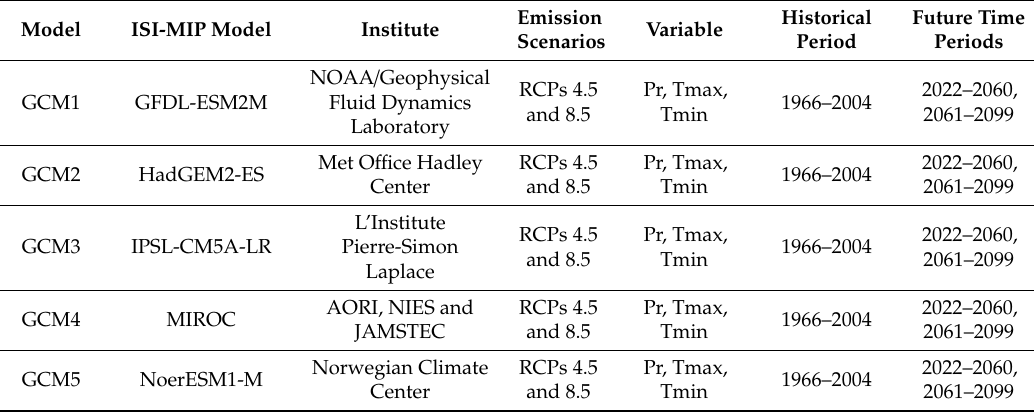
Table 1. Details of the general circulation models (GCMs) used for the projection of the precipitation and maximum / minimum temperature in the Vakhsh River Basin. The emission scenarios (RCPs) and the time periods considered in the calculation of the change factors and future climate change impacts on streamflow are also